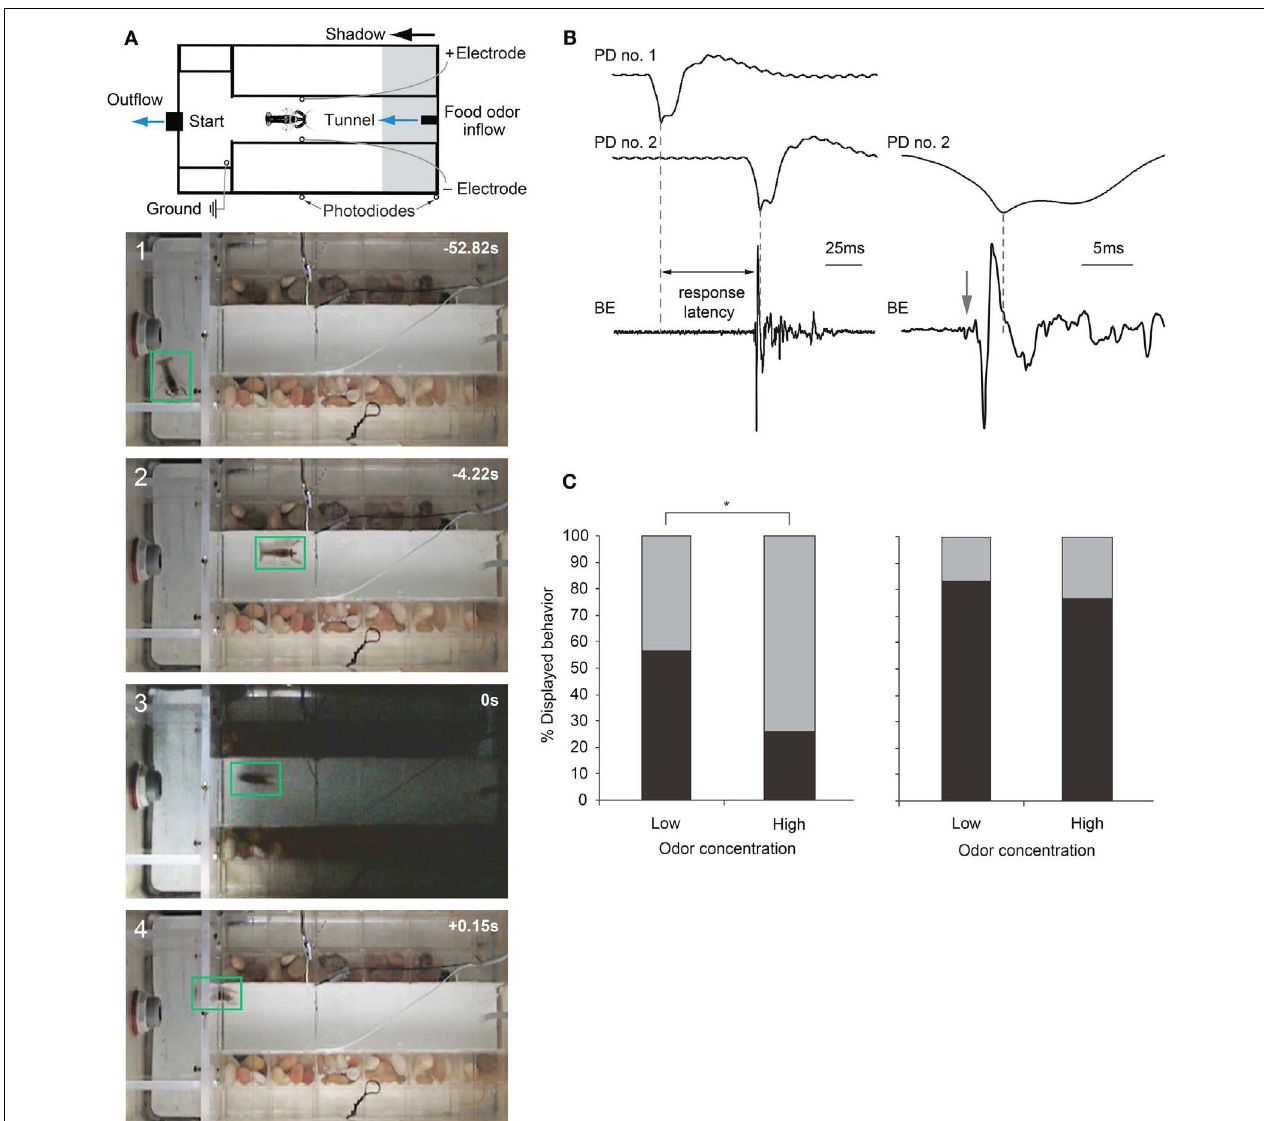
collided with the animal and produced the peak response in PD no. 2.The first small deflection (arrow) in the BE trace is due to MG neuron activation, while the large phasic potential and the smaller more erratic potentials that follow are due to muscular activity during tail-flips. (C) Left: when exposed to a medium speed shadow (2m/s), crayfish produce fewer tail-flips (black bars) and more freezing (gray bars) when food odor concentration flowing through the tank is high. Right: when exposed to slower (1m/s) shadows, the effect of food odor concentration on behavioral choice is less pronounced. (A) Modified from Liden and Herberholz (2008). (B,C) Modified from Liden et al.